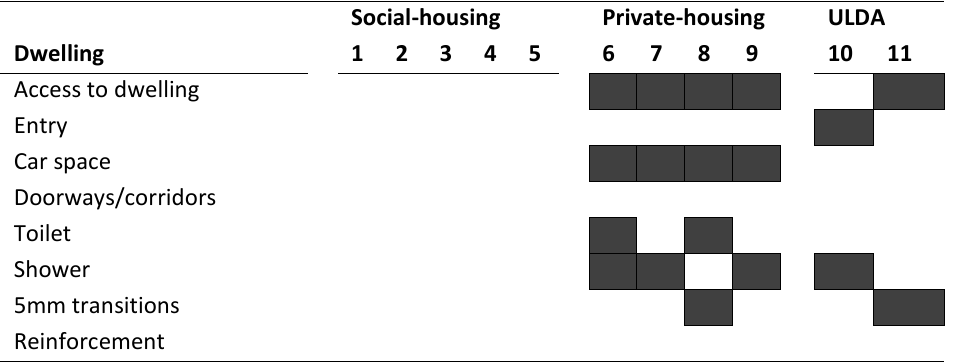
Table 4. Compliant features due to “fashion”.